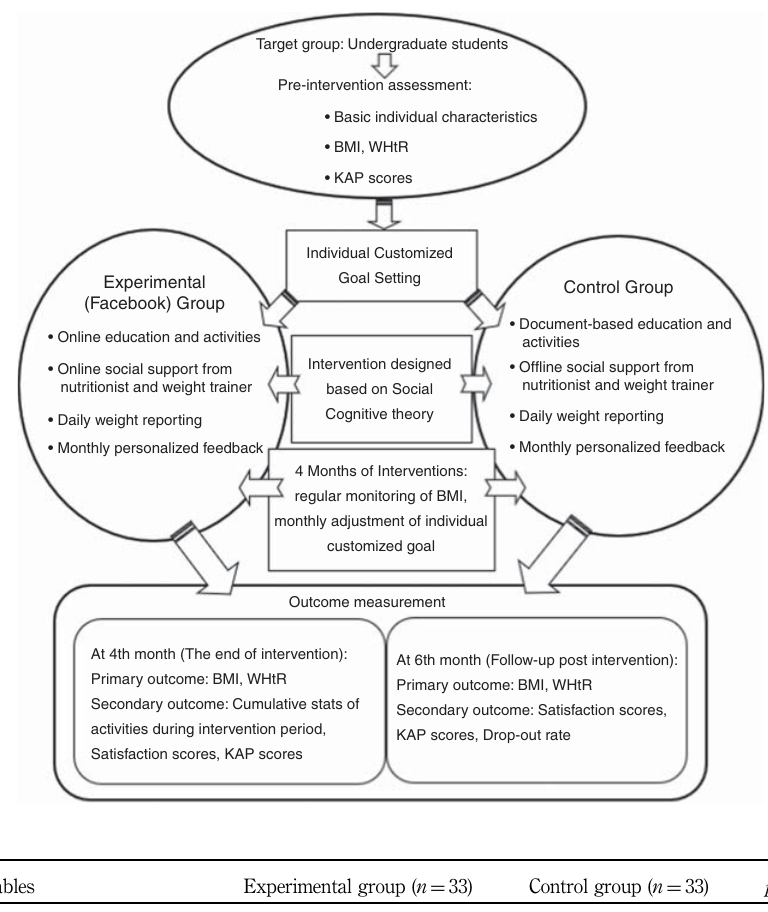
characteristics of the sample: age, GPA, monthly income, BMI, WHtR for continuous data, sex and academic year for category